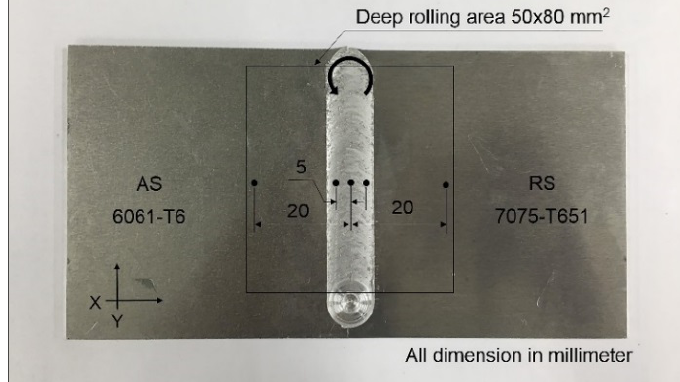
Figure 7. Residual stress measurement position.